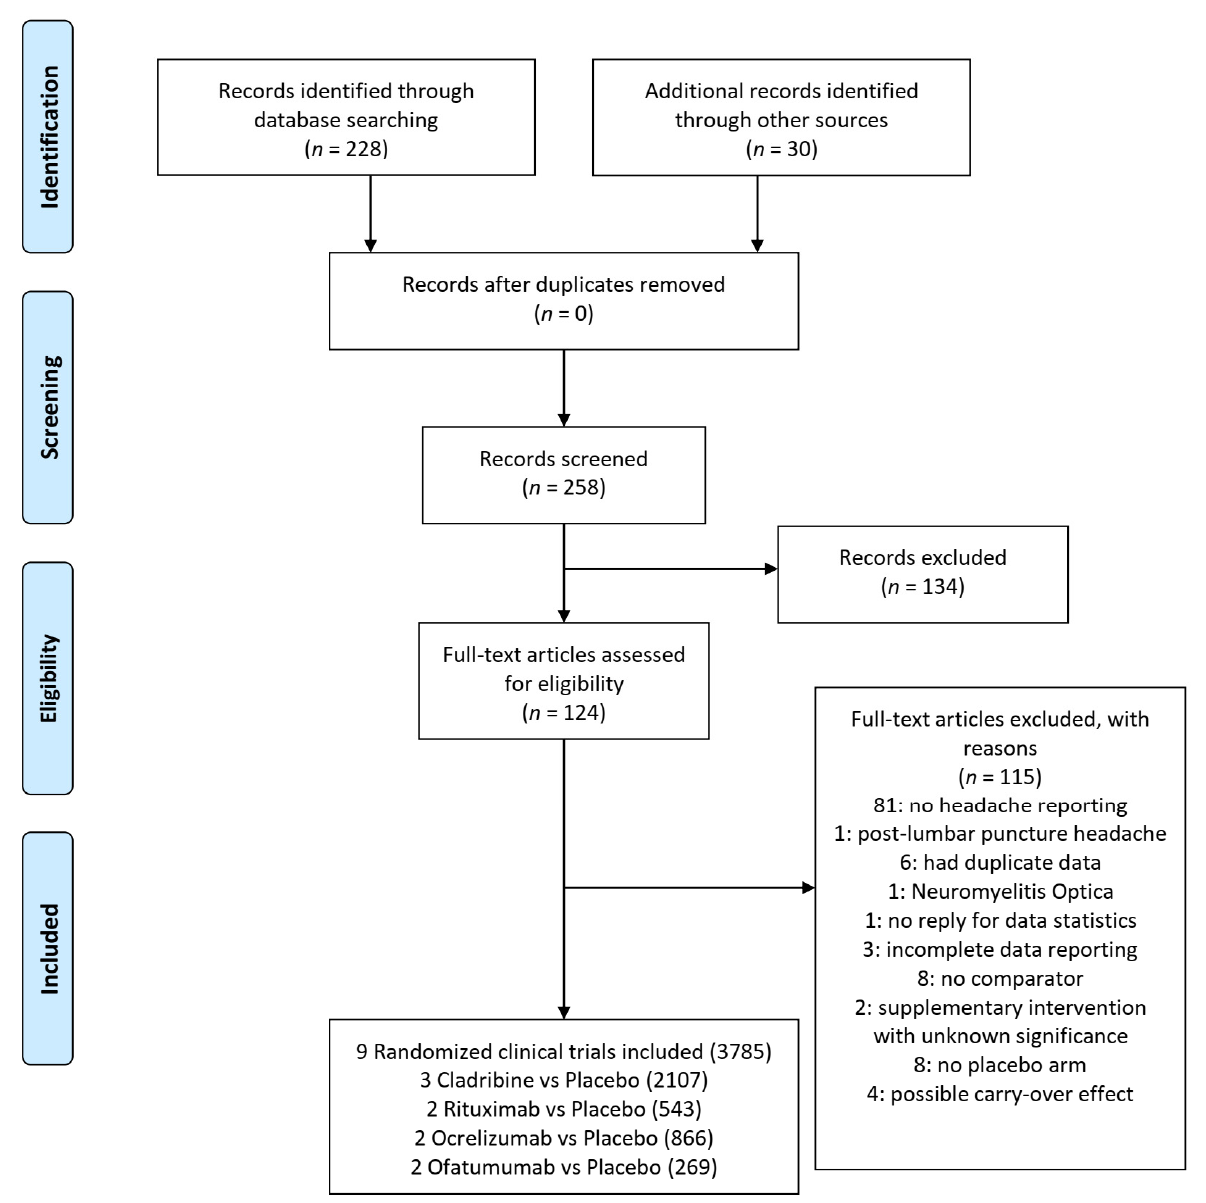
Figure 1. PRISMA Flow Diagram.